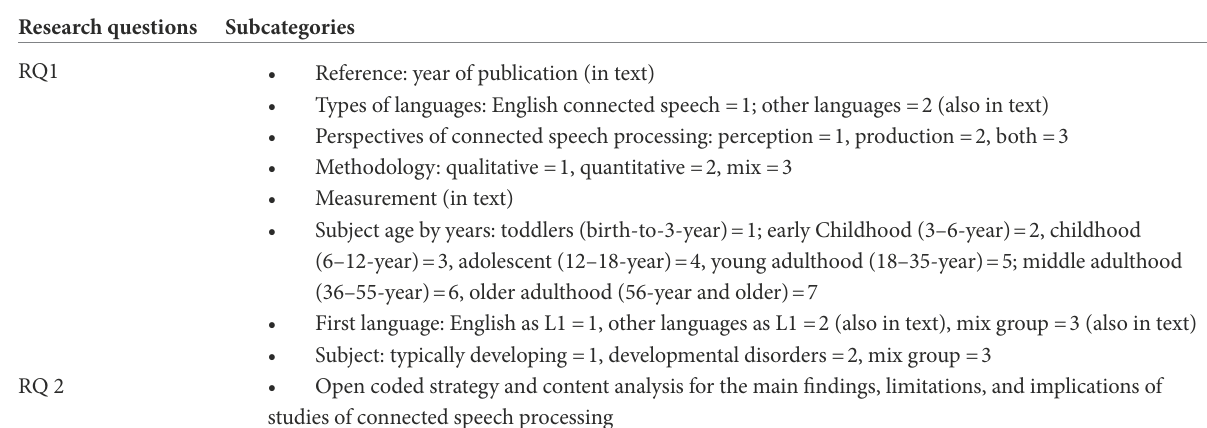
TABLE 1 Subcategories of research questions.